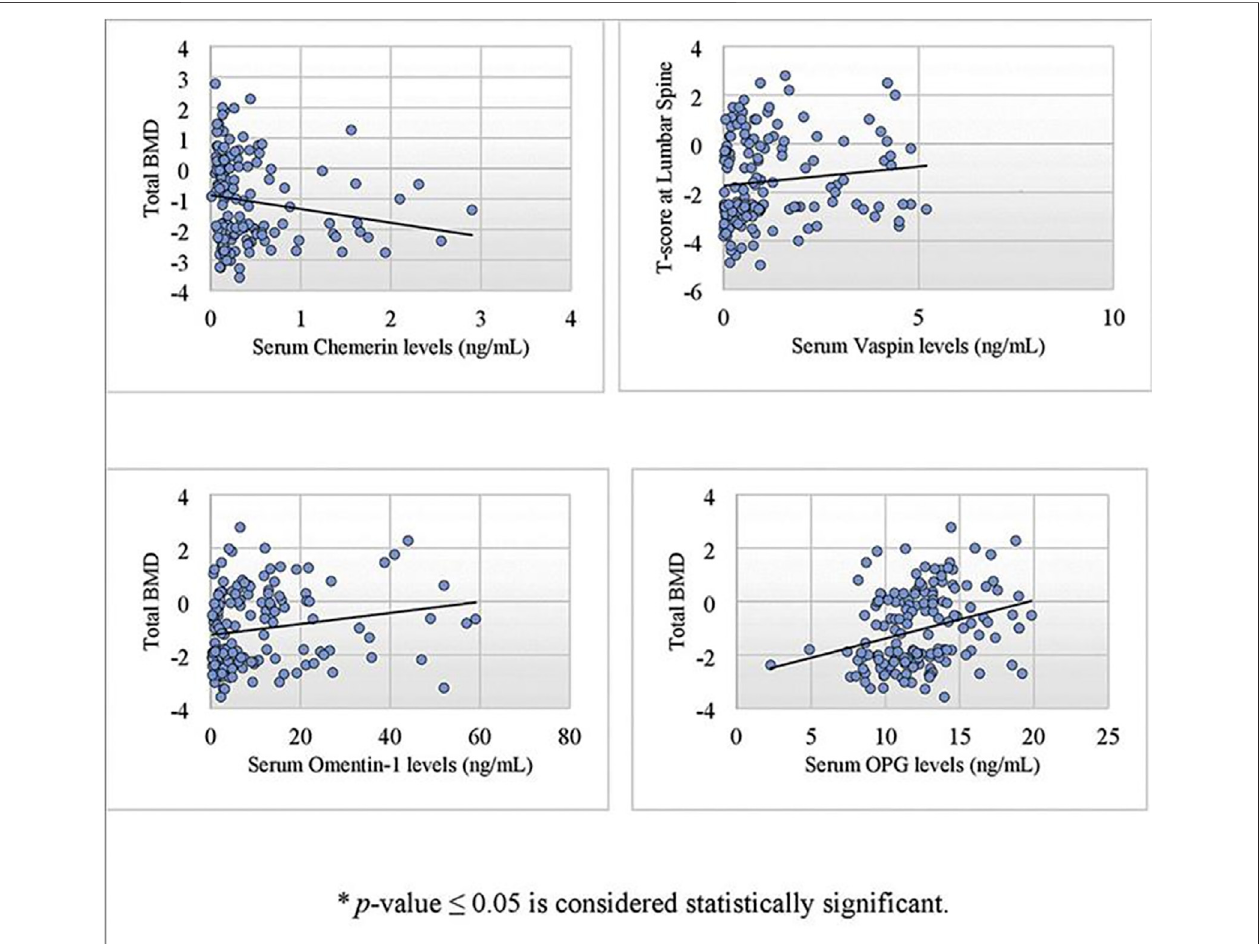
FIGURE 1 | Scatter plot showing a signi fi cant correlation of serum chemerin, vaspin, omentin-1 and OPG with bone mineral density in postmenopausal females using spearman ’ s rho correlation coef fi cient.